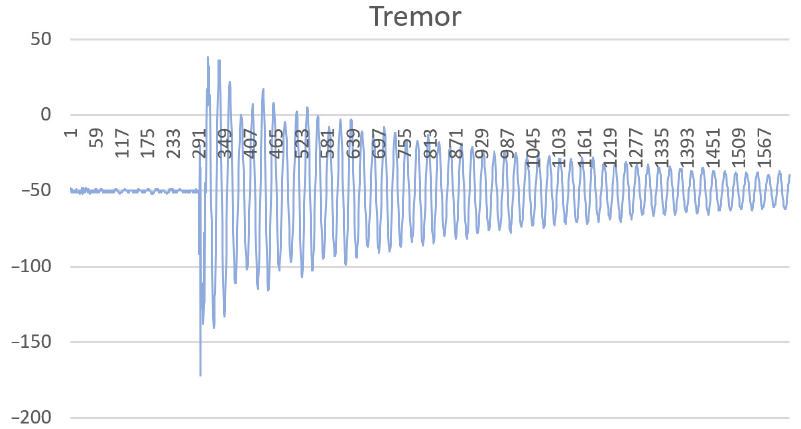
Figure 8. The fading harmonic oscillation obtained as a result of the activation of the tuning fork. Figure 9 shows the result of measuring the isometric component of force and tremor in a healthy person in two tests differing in the value of applied isometric force. The values of the series in Figure 9a–d correspond to the code taken from the ADC and are proportional to the amplitude of the signal. The marks on the x -axis are the number of the samples in the time series. The difference between time samples corresponds to approximately 0.00102 sec, which is reflected in Table 1.